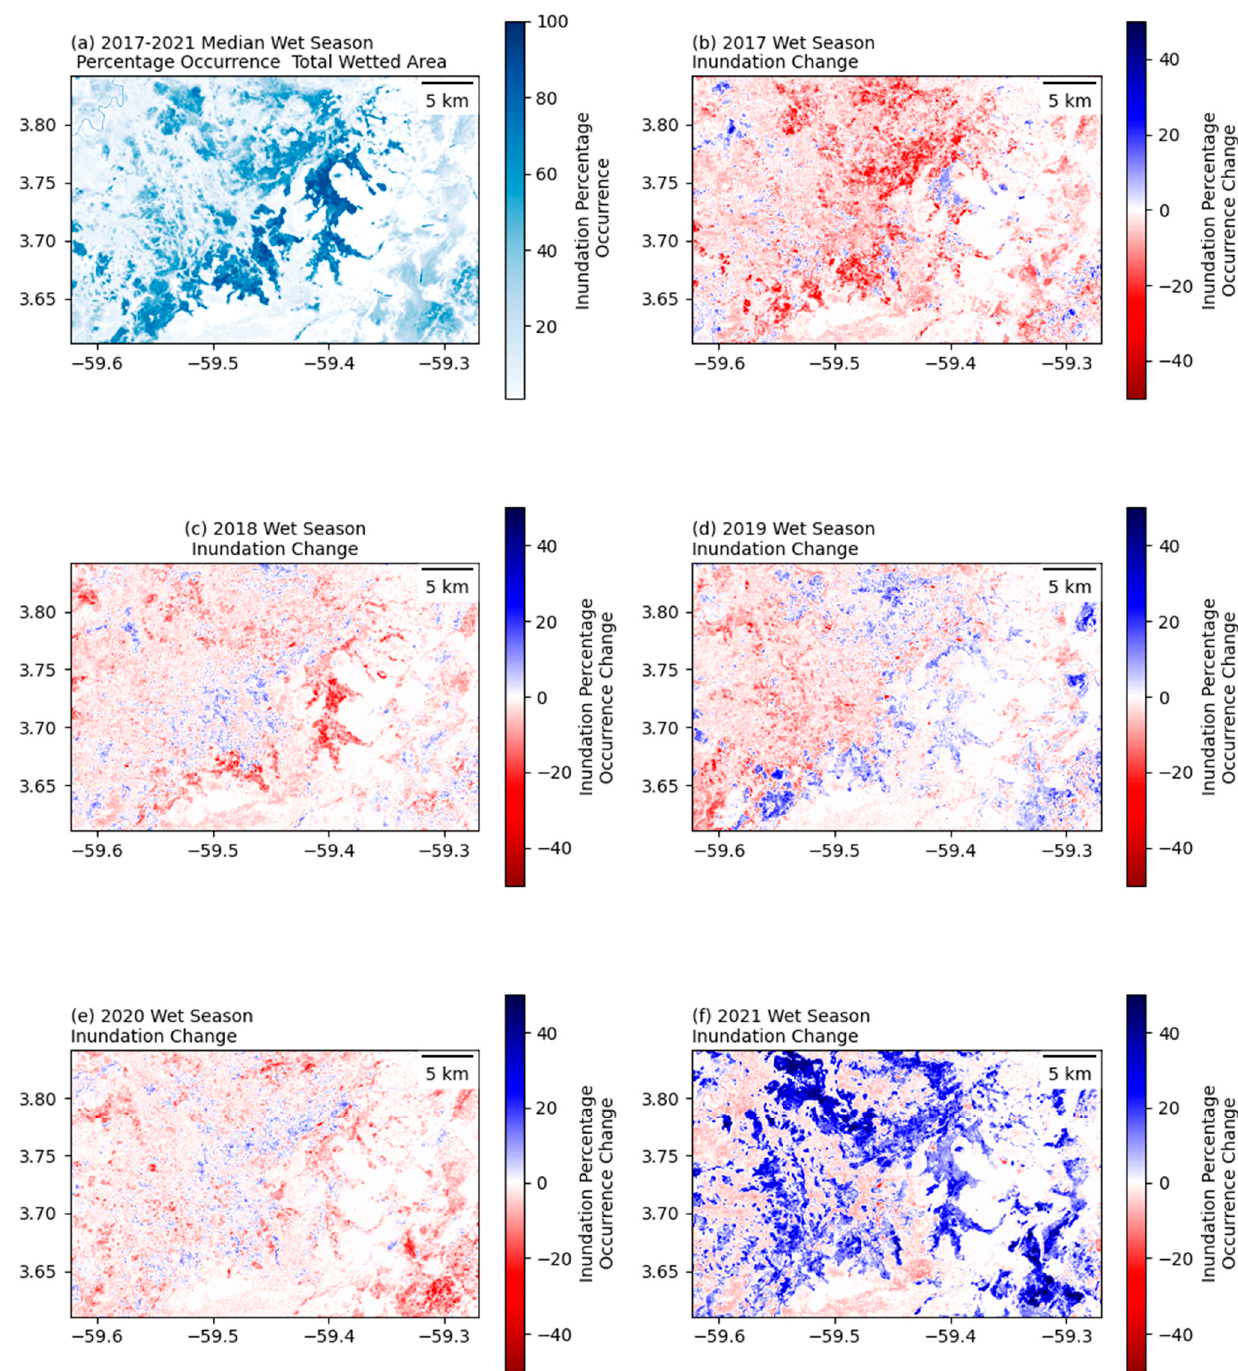
Figure 17. ( a ) Median % wet season inundation occurrence for the Upper Rupununi wetlands over the period 2017–2021 and subsequent % deviation in inundation occurrence annually: ( b ) 2017, ( c ) 2018, ( d ) 2019, ( e ) 2020, ( f ) 2021.